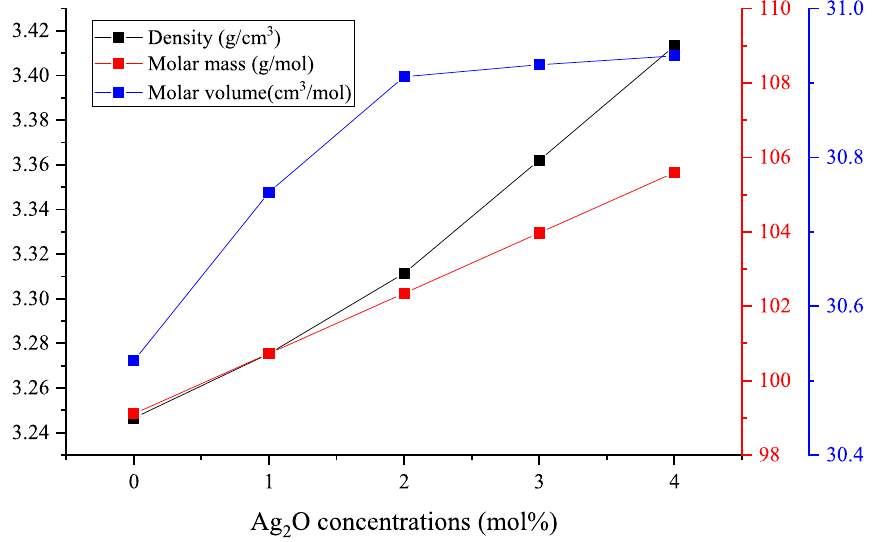
Figure 2. The variation of glass density, molar mass, and molar volume versus the doped Ag 2 O ratio.